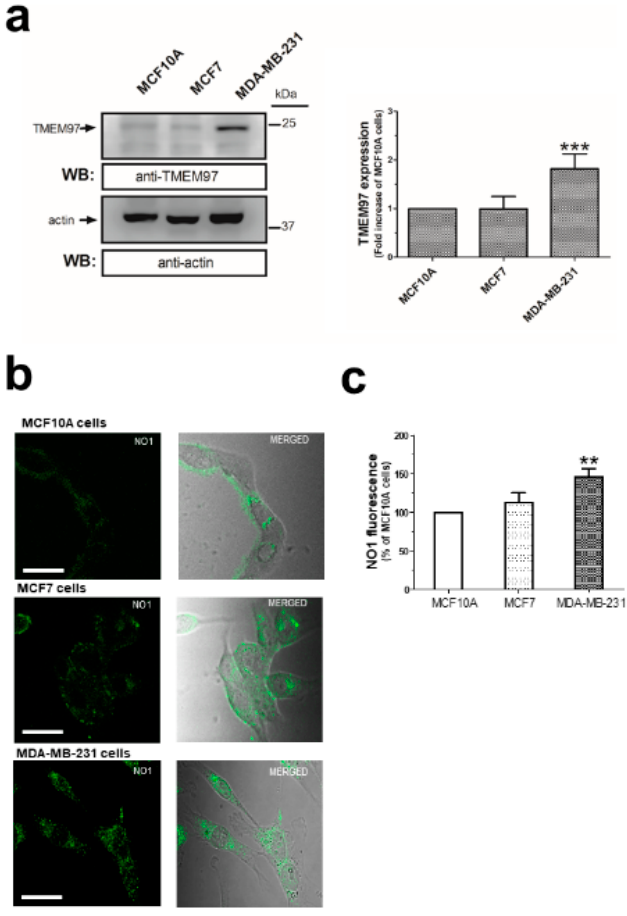
Figure 1. σ 2R / TMEM97 expression in MCF10A, MCF7, and MDA-MB-231 cell lines. MCF10A, MCF7 and MDA-MB-231 cells were shed onto coverslips at the same concentration (1 × 10 6 cells / mL). ( a ) Cells were detached and lysed with Laemmli’s bu ff er for subsequent WB using a specific anti-TMEM97 antibody as described in the Material and Methods section. Bar graph represents the fold increase of σ 2R / TMEM97 expression relative to MCF10A normalized with the actin content that was used as loading control. ( b ) Alternatively, coverslips were incubated for 5 min with 100 nM of NO1 at room temperature and were mounted under a confocal fluorescent microscope, where samples were excited at 390 nm. The resulting NO1 fluorescence was acquired at a wavelength of 505 nm. Images were focused in the middle-cell plane, using a 40 × -immersion oil objective, and are representative of three independent experiments. Bar represents 30 µ m. ( c ) Cells treated with NO1, as described above, were detached, washed, and resuspended in 1 mL of PBS inside a quartz cuvette. NO1 fluorescence emitted by the samples was recorded using a spectrofluorophotometer (Ex / Em: 390 nm / 505 nm). Bar graph represents the percentage of NO1 fluorescence compared to the values found in MCF10A, presented as the mean ± S.E.M. of five independent experiments. **, ***: represent p < 0.01 and < 0.001 as compared to